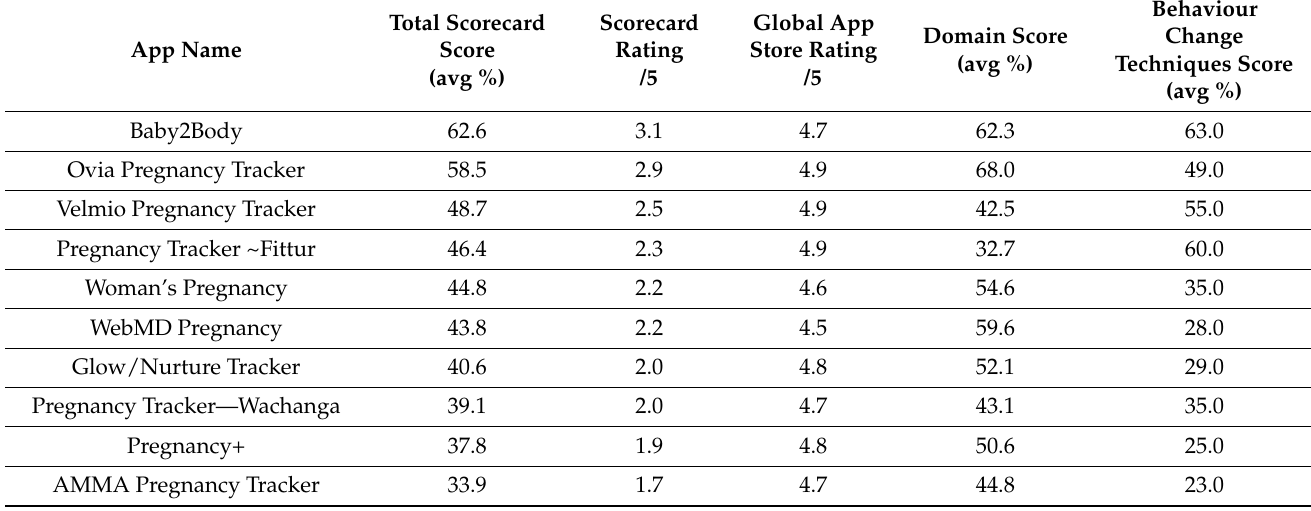
Table 3. The top 10 pregnancy apps. Top 10 pregnancy apps based on their domain (technical, clinical, usability, cost and time, and user requirements) and their behaviour change technique scores compared to their app store